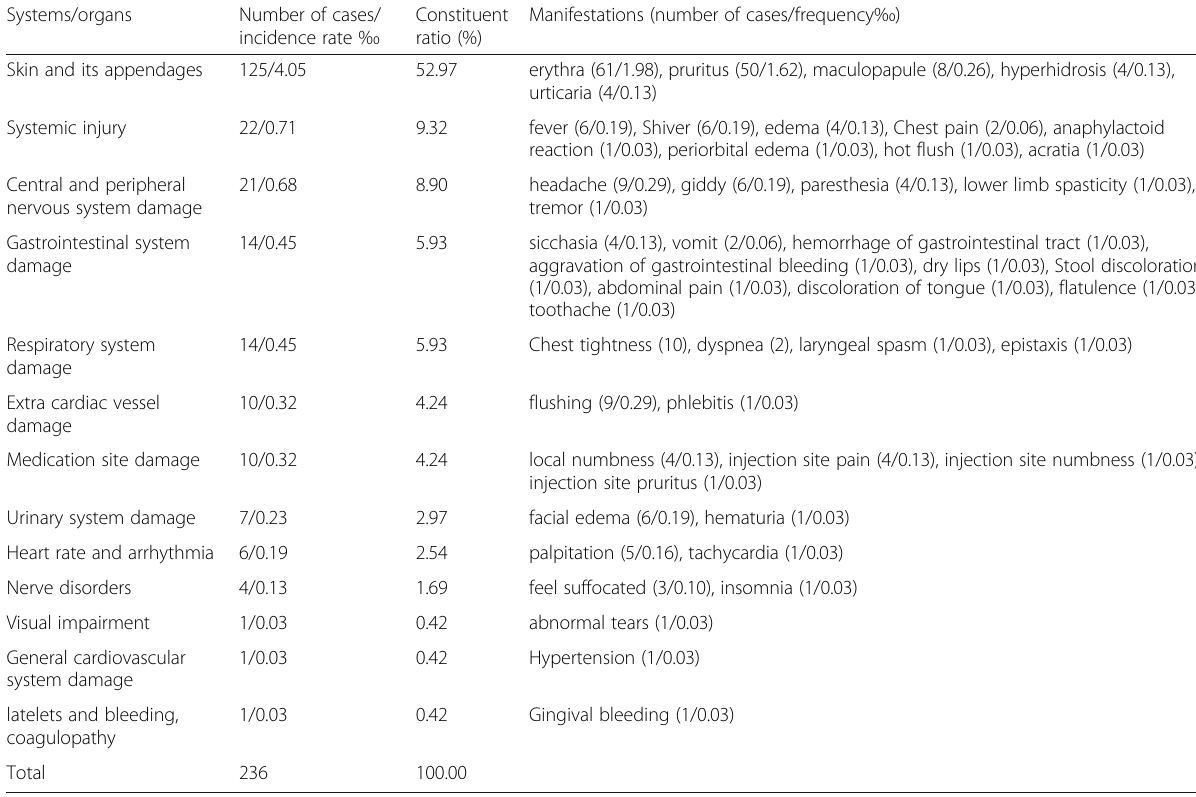
Table 3 ADR manifestations of XSTI Systems/organs